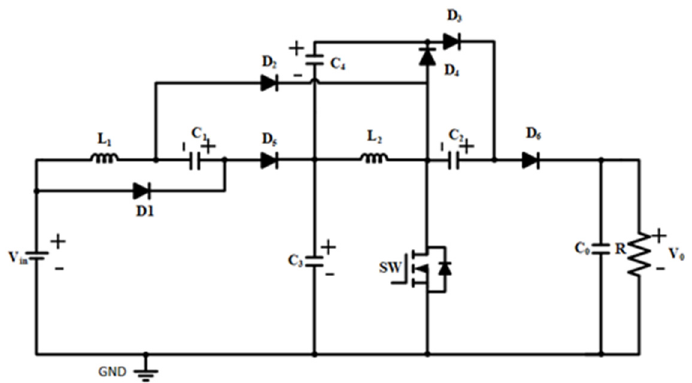
Figure 5. Circuit diagram of the Proposed converter.